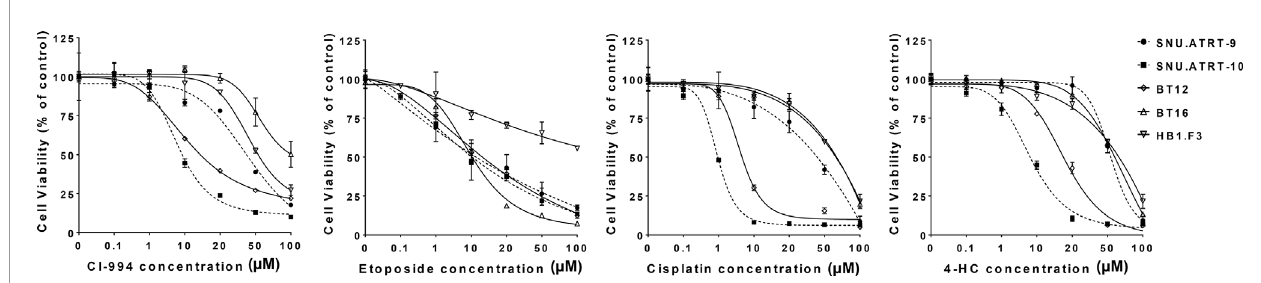
FIGURE 2 | Single treatment in AT/RT cells. The viability of AT/RT cells against selected drugs (CI-994, etoposide, cisplatin, or 4-HC) was assessed by estimating their IC50.